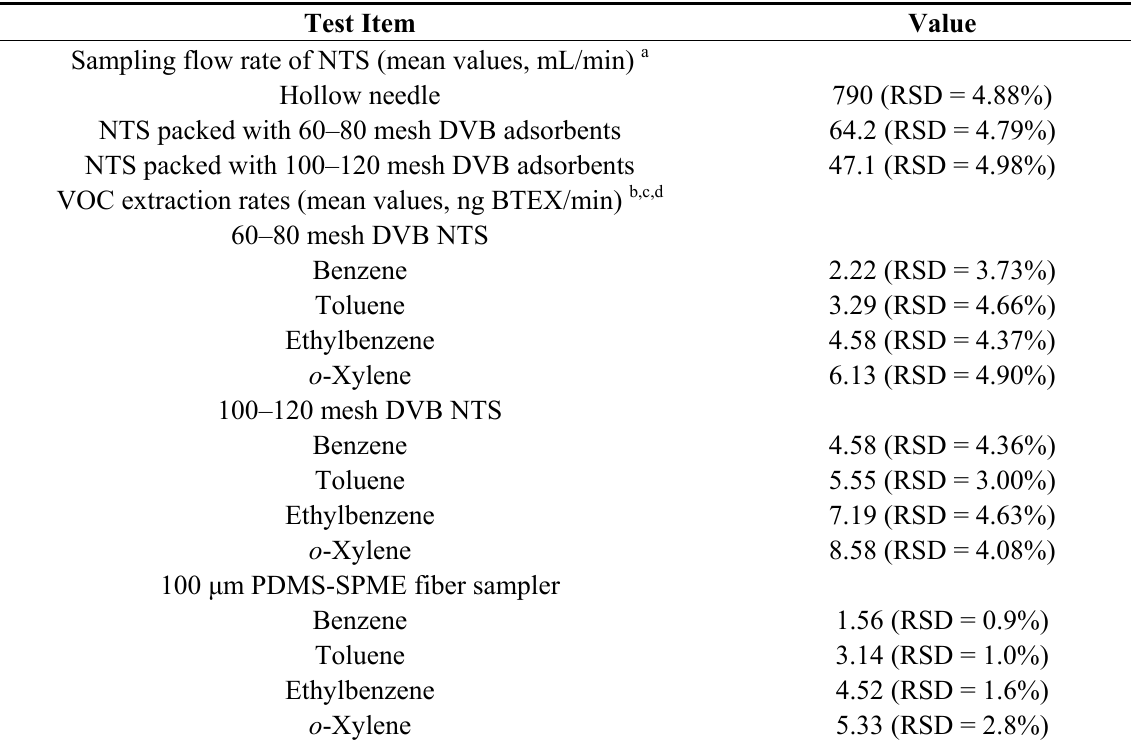
Table 2. Tests of sampling flow rates and volatile organic compound (VOC) extraction rates by solid phase microextraction devices in this